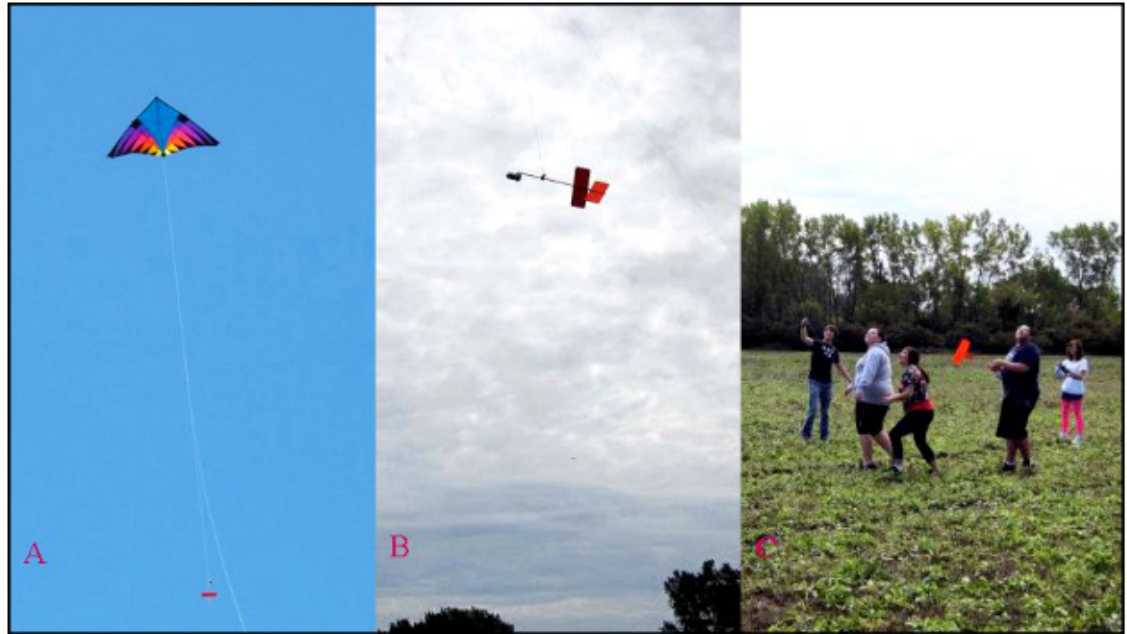
Figure 1. A composite photo of fying the Aeropods: Panel A – the kite; Panel B – the Aeropods; Panel C – the fying crew of